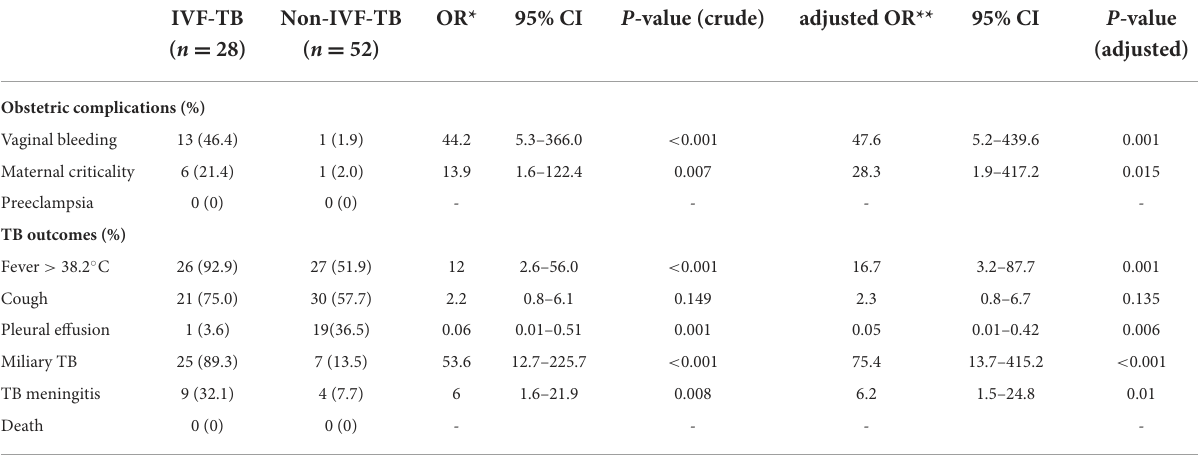
TABLE 2 Association between IVF status and maternal outcome among TB-in-pregnancy women.